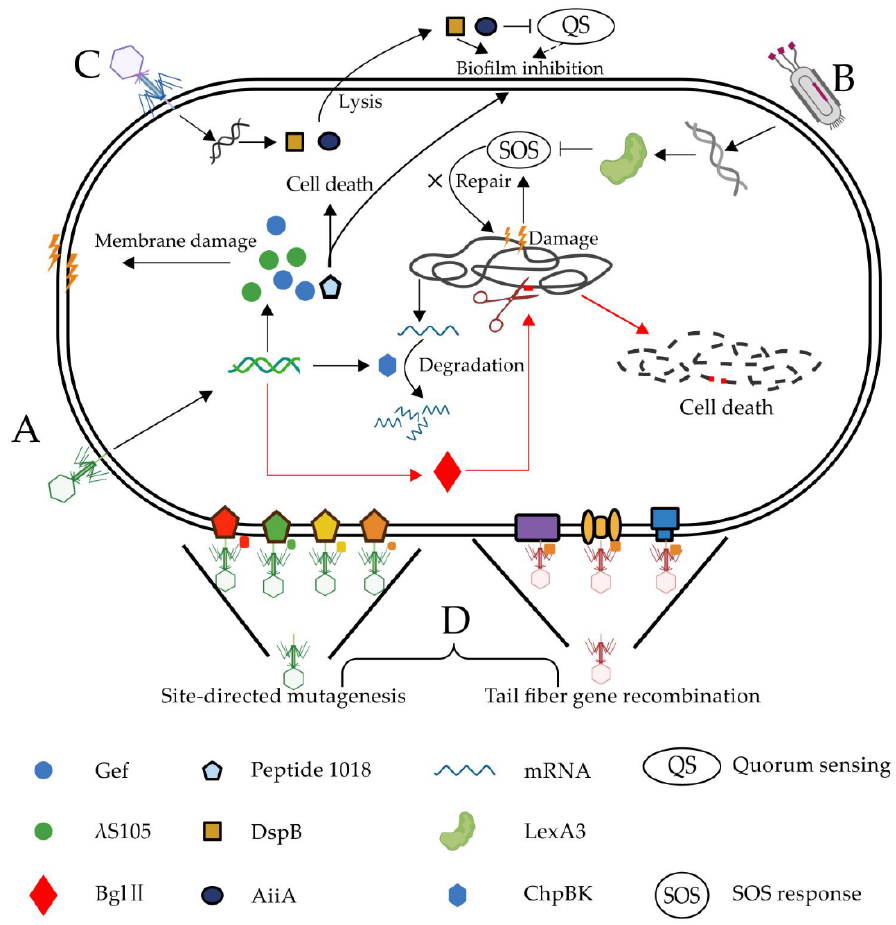
Figure 1. Phage genetic modification strategy against bacteria. Phages are engineered to enhance the bactericidal efficacy by ( A ) expressing toxin proteins, including λ S105, Bgl II, ChpBK, Gef, and peptide 1018; ( B ) suppressing the SOS response (SOS) repair system by overexpressing repressor protein LexA [20]; ( C ) degrading and inhibiting the biofilm using DspB and AiiA, respectively; and ( D ) re-editing the phage tail fiber genes to expand the phage host range [25–28]. Hagens et al. [18] inserted λ S105 and Bgl Ⅱ toxin genes into the genome of phage M13. Phage protein λ S105 is a holin protein that could damage the bacterial membrane